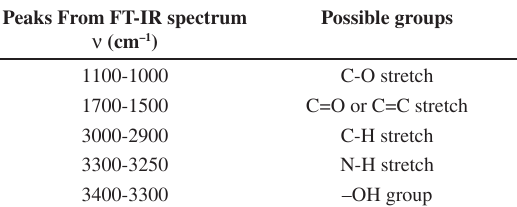
Figure 1. FT-IR transmittance spectra of mad Table 2. FT-IR transmittance spectrum of mad honey and its identification.